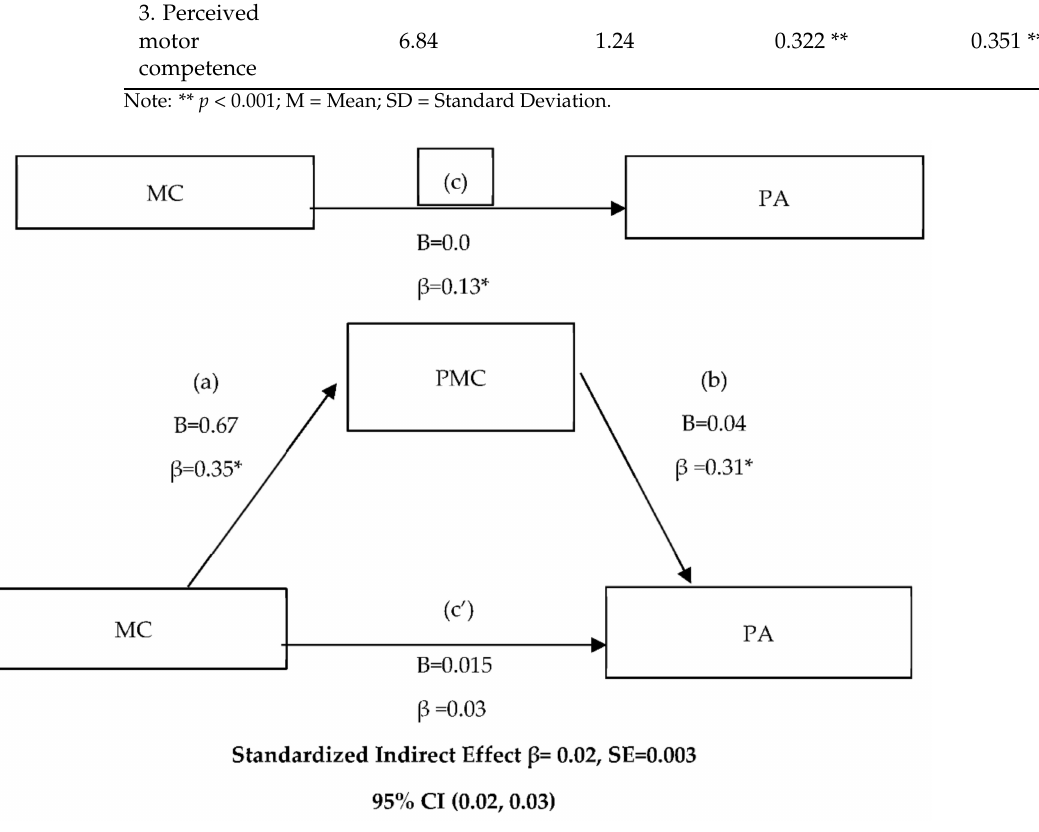
Figure 1. Simple mediation analysis of motor competence on the physical activity in relation to per- ceived motor competence. ( a ) the equation that regressed perceived motor competence on the motor competence, ( b ) the equation that regressed physical activity and perceived motor competence, ( c ) the equation that regressed motor competence and physical activity, and finally ( c’ ) the equation that regressed the IE of perceived motor competence on the relationship between motor competence and Physical Activity. B: Unstandardized regression coefficient; β : Standardized regression coefficients; SE: Standard error, CI: Confidence interval. * Statistically significant at p =